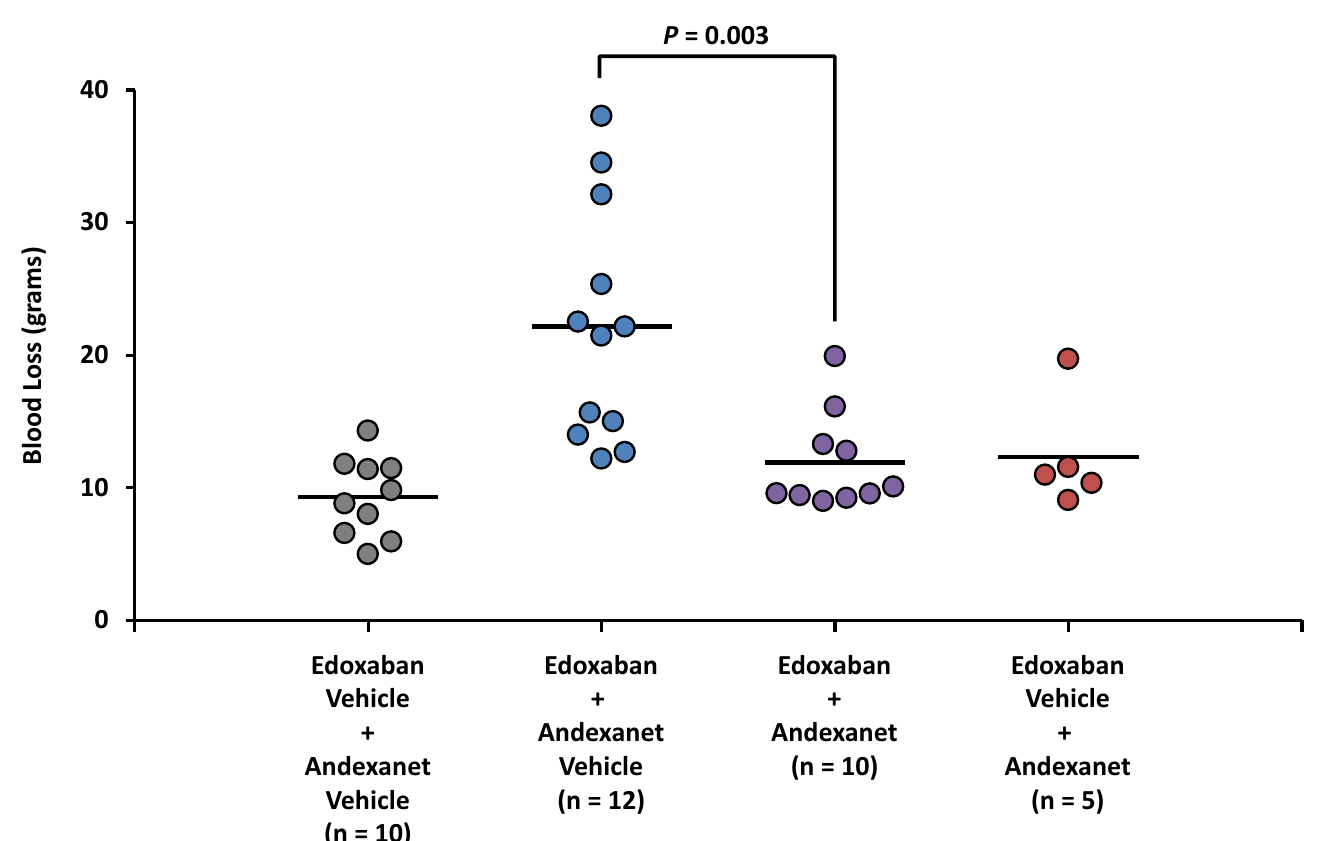
Fig 5. Total blood loss at end of study. The procedure for the rabbit liver injury prophylactic blood loss model was a modification of a previously published hepatosplenic liver injury model as described in Materials and Methods. Rabbits were administered edoxaban (1 mg/mL) or edoxaban vehicle at Time 0. Andexanet or andexanet vehicle was administered IV over 5 minutes (from Time 20 to Time 25 minutes). A standardized liver injury was made into 2 liver lobes with 5 incisions in each lobe and allowed to bleed for 15 minutes (from Time 25 to Time 40 minutes). The blood loss was measured in grams by weighing pre-weighed dry gauze. Each data point represents the measurement from an individual rabbit at Time 40 minutes (15 minutes after liver injury). Horizontal bars represent mean values.